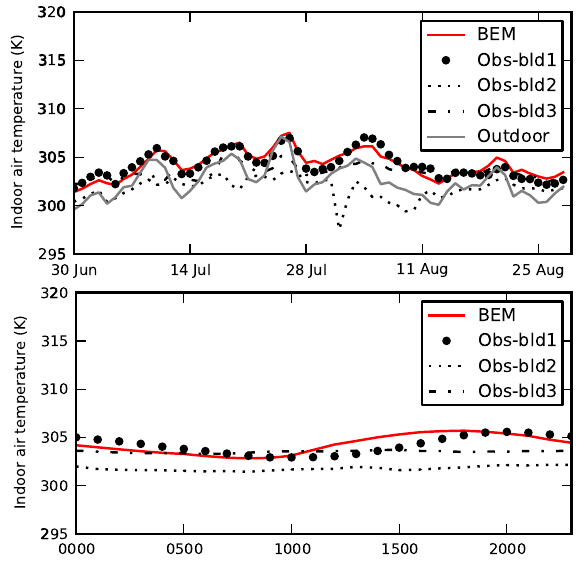
Fig. 11. Daily-average (top) and monthly-averaged diurnal cycle (bottom) of indoor air temperature from observations and calculated by BEM-TEB from 30 June to 30 August for the Egaleo neighbour- hood of Athens. Observations correspond to three different resi- dential buildings. Daily-average outdoor air temperatures are also represented